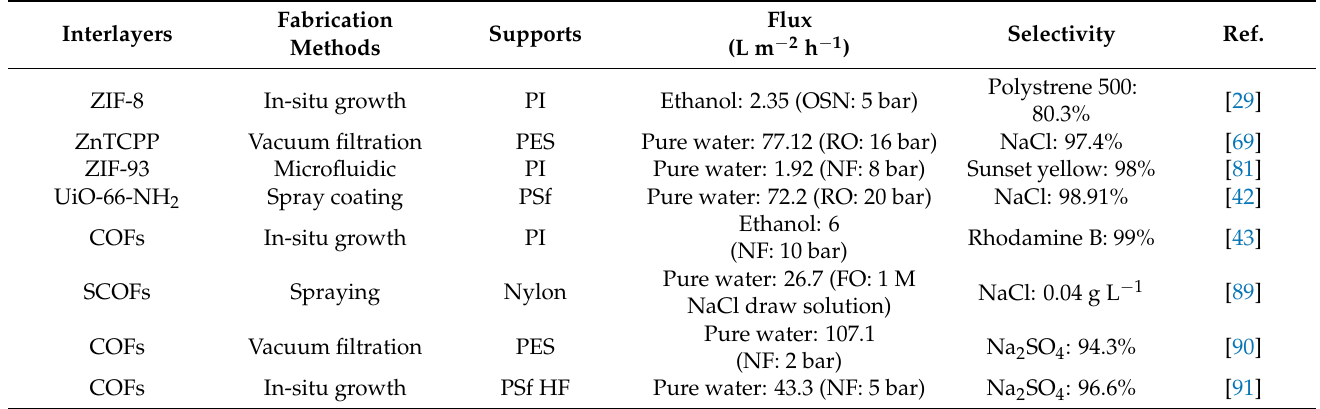
Table 2. Performances of 2D MOF and COF nanosheets intercalated TFNi